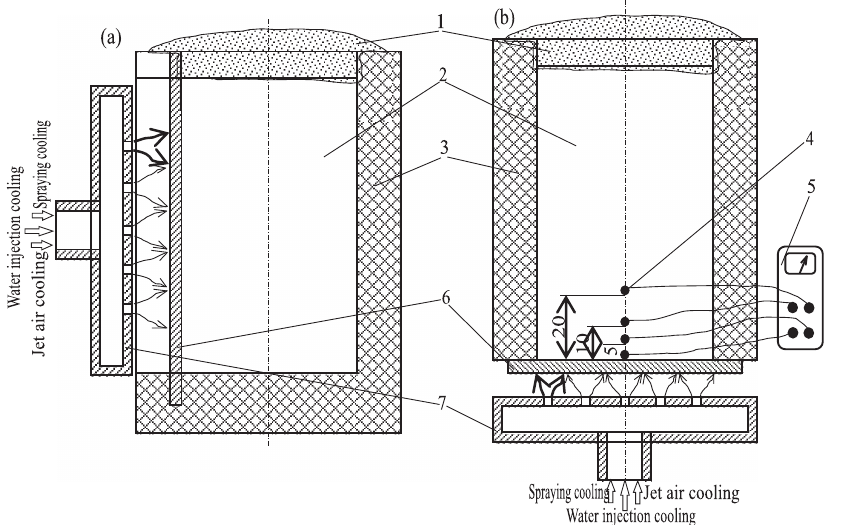
Figure 1: Schematic plan of preparing Cu/Al composite castings by the pouring method: (a) vertical pouring and (b) horizontal pouring. (1) Covering agent for thermal retardation; (2) Al liquid; (3) casting mold; (4) thermal couple; (5) DMR2100 paperless recorder; (6) copper plate; (7) cooler.